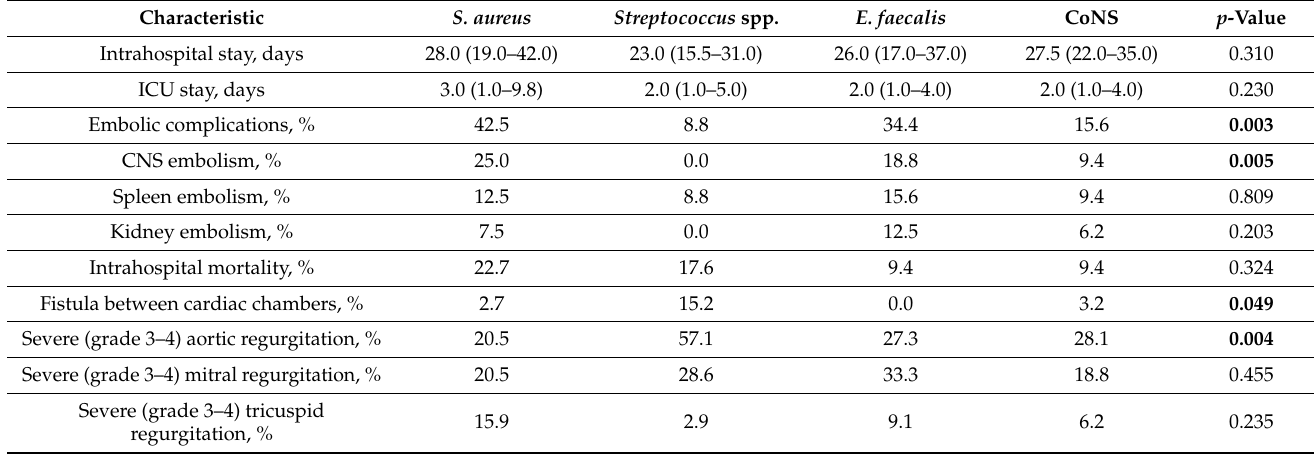
Table 4. Clinical outcomes and complications of IE caused by various bacterial agents.